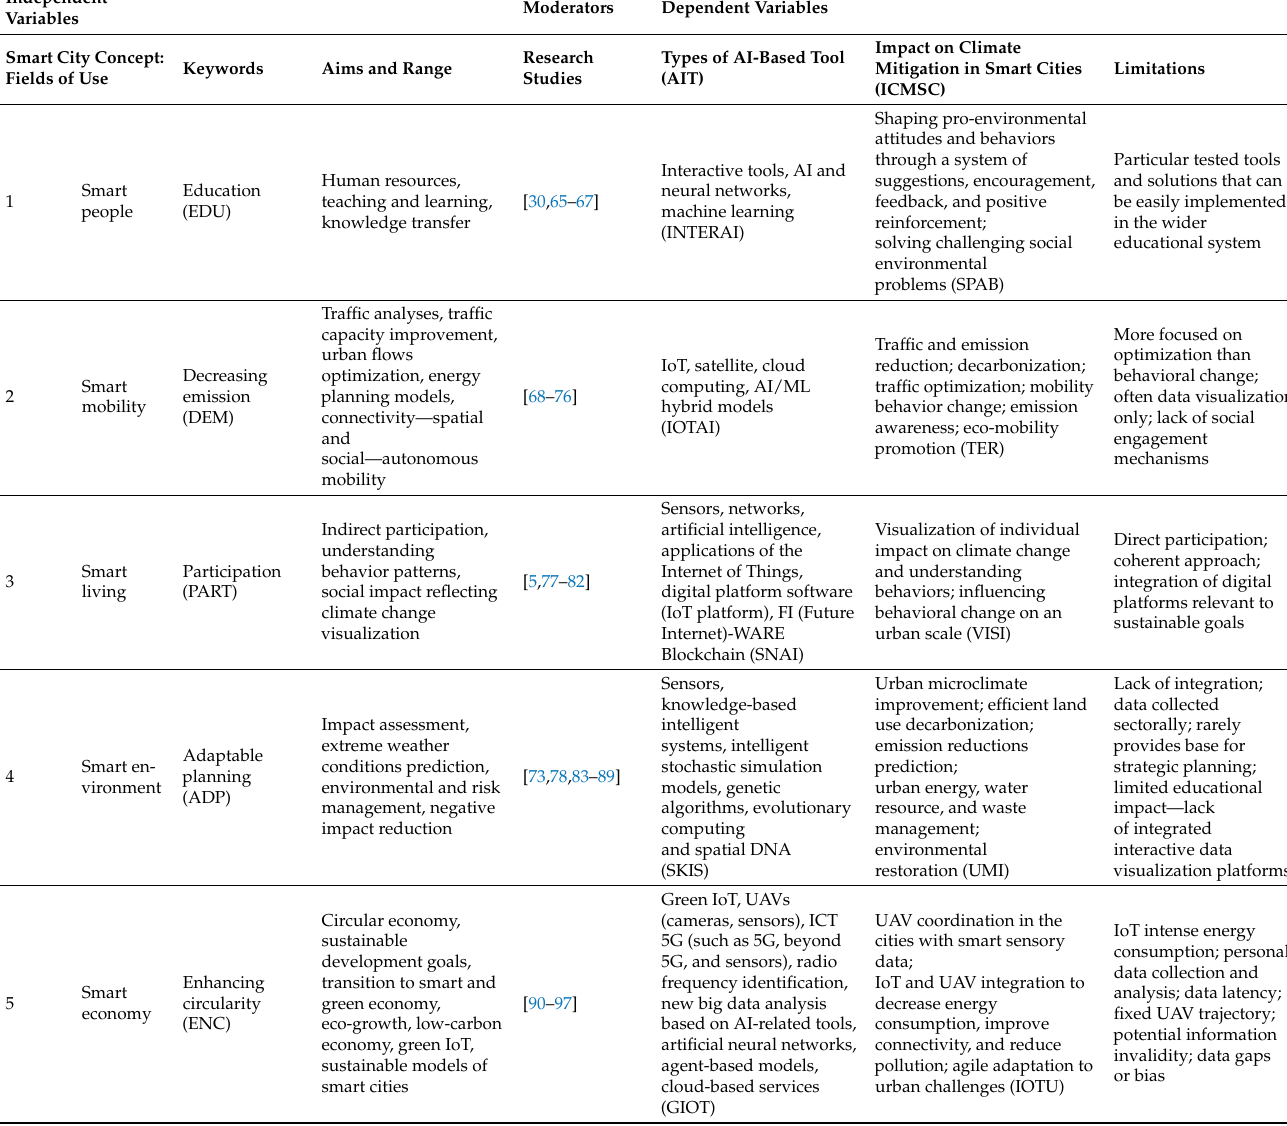
Table 2. The results of case studies’ analysis and evaluation. Authors’ own